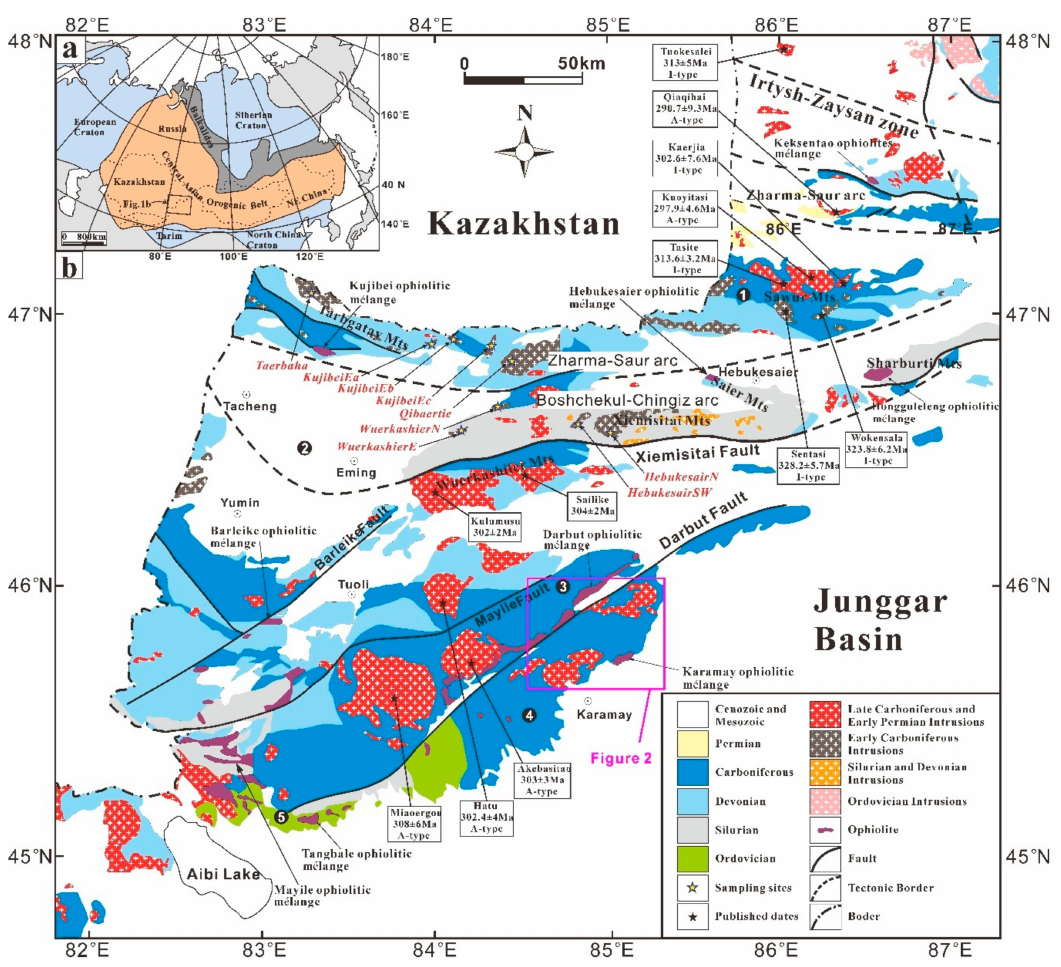
Figure 1. ( a ) Simplified tectonic divisions of the Central Asian Orogenic Belt (modified after Jahn et al. [5]; Yakubchuk [22]); ( b ) simplified geological map of the West